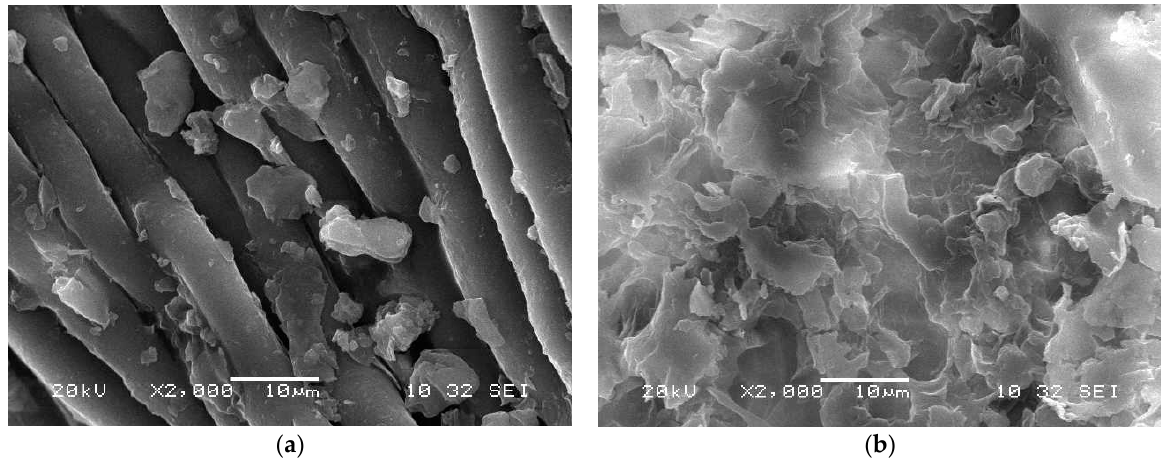
Figure 2. Scanning Electron Microscope (SEM) images of the AILP surface ( a ) before and ( b ) after adsorption.